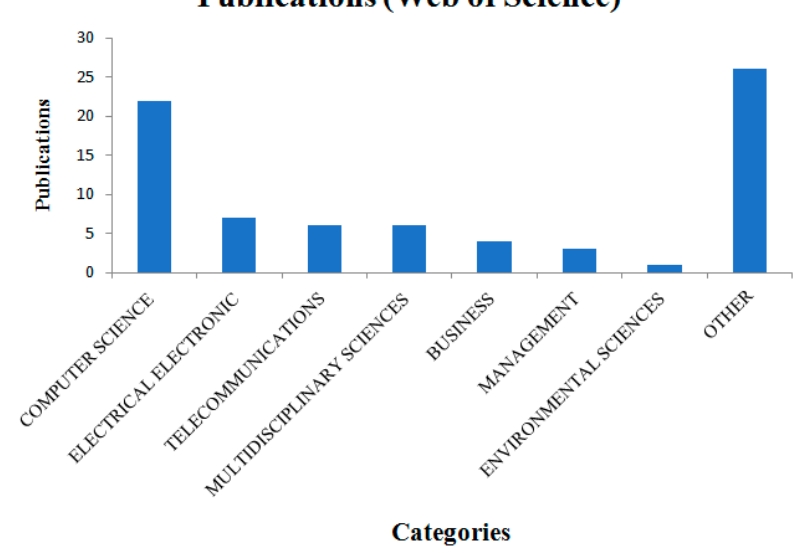
Figure 1. Web of Science database literature search results for ‘blockchain’. Note: Category ‘Other’ does not include agriculture-related disciplines.